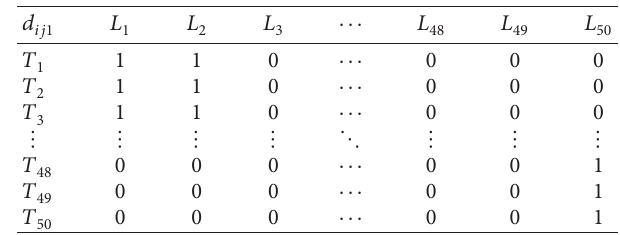
Table 8: Profit and loss matrix D location.